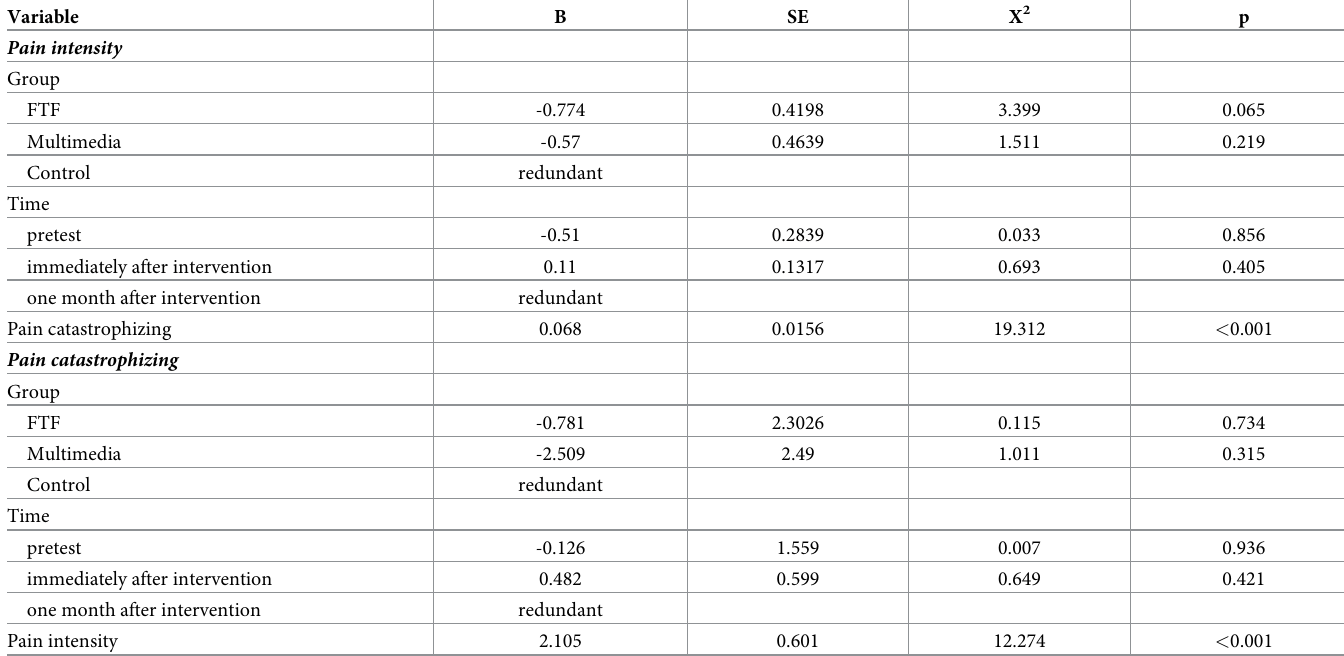
Table 4. Effect of intervention and covariate factors on pain catastrophizing and pain intensity using generalized estimating equations (GEE).